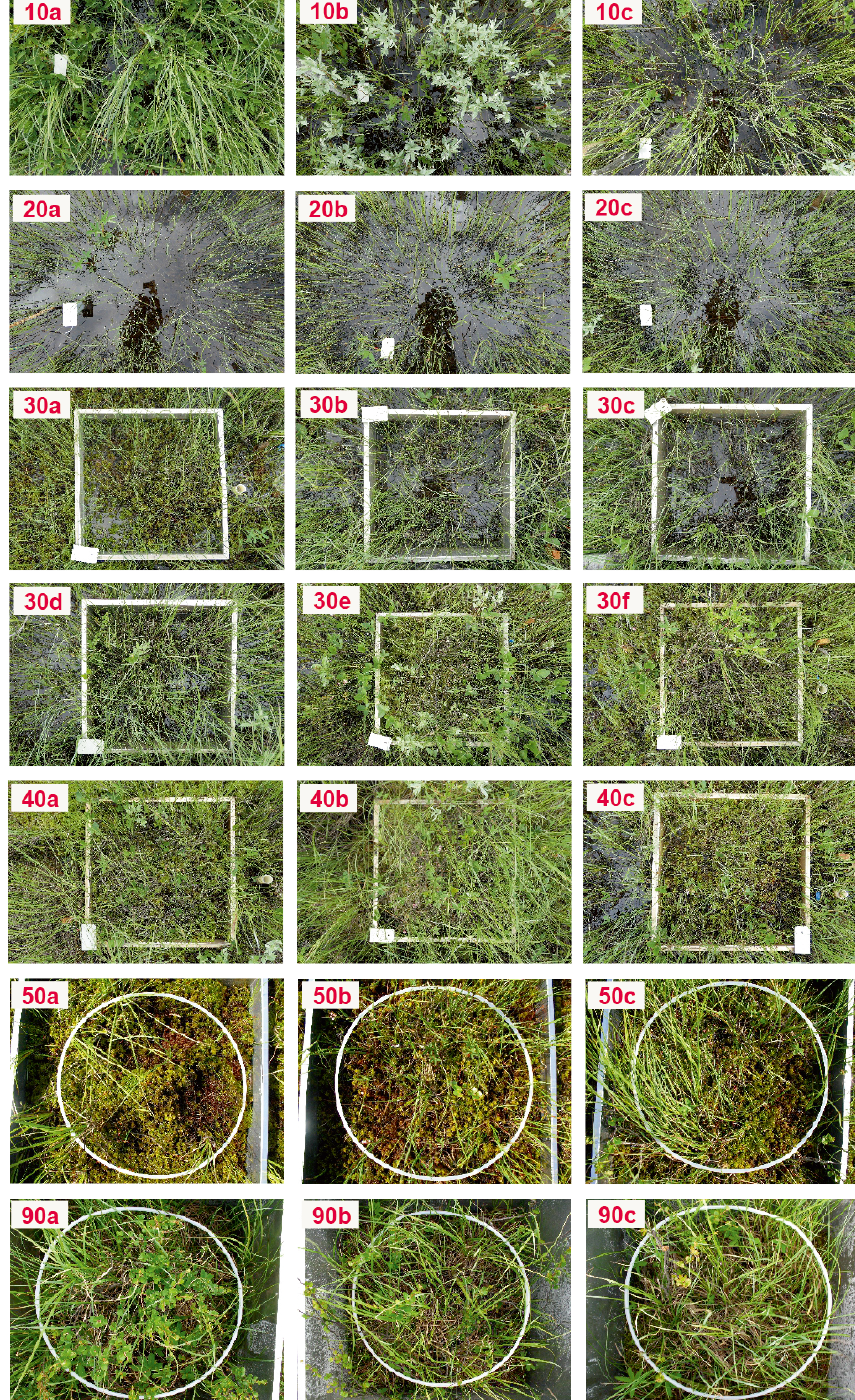
Figure A3. Photos of the methane (CH 4 ) flux sample plots at Lompolojänkkä taken on 1 July 2019 (sets 10 to 40) and 28 June 2019 (sets 50 and 90). Photos were not taken for set